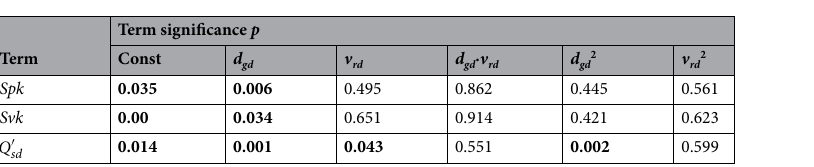
′ sd . Lower values are more